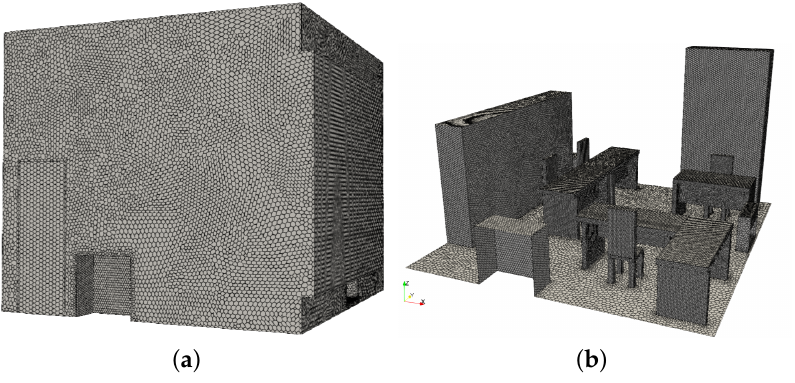
Figure 3. Final mesh. ( a ) View of the mesh from outside of the office; ( b ) view of the